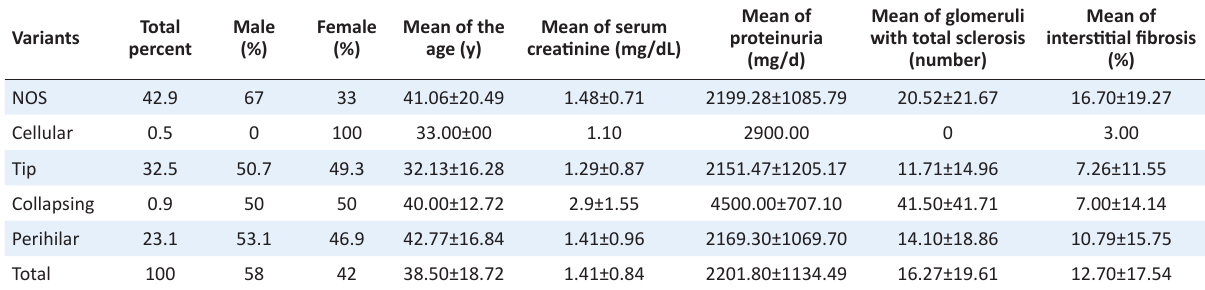
Table 1. Patients’ data